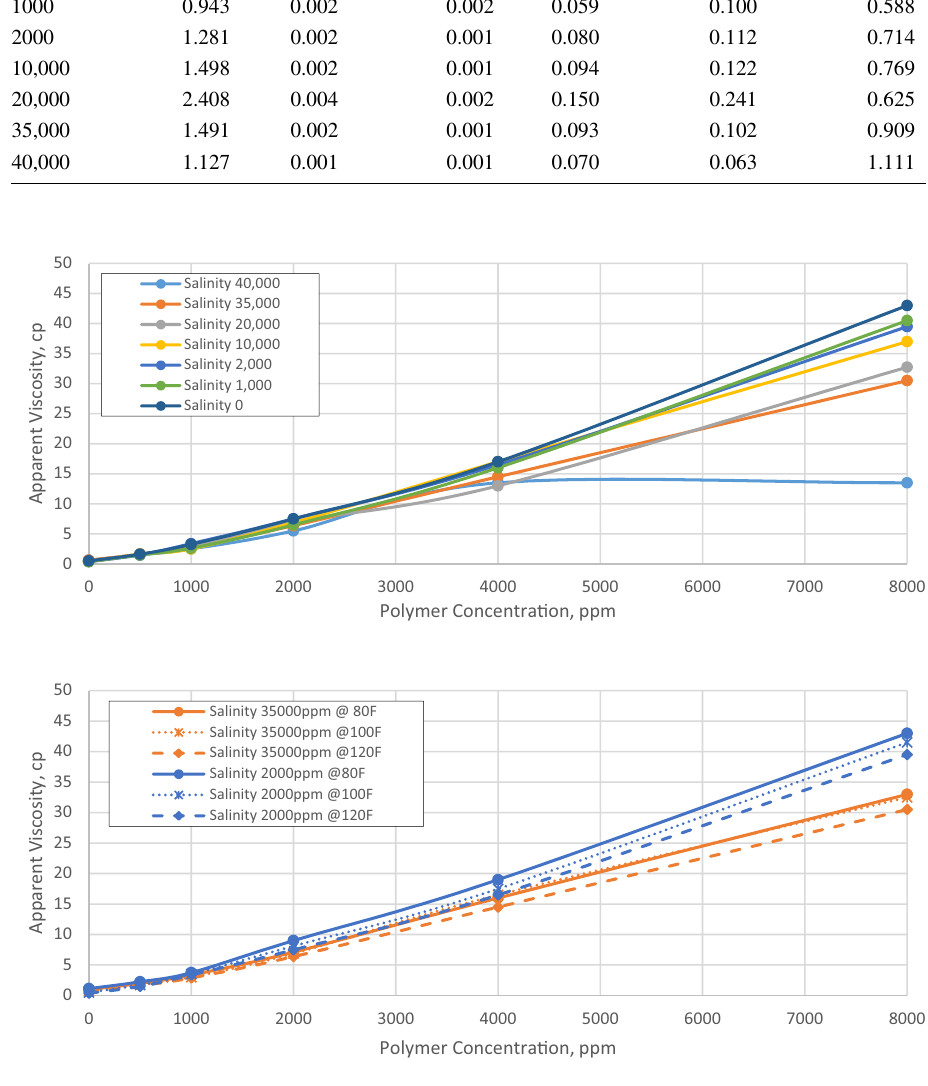
parameters for 1000 ppm refined xanthan gum to be entered into the simulator